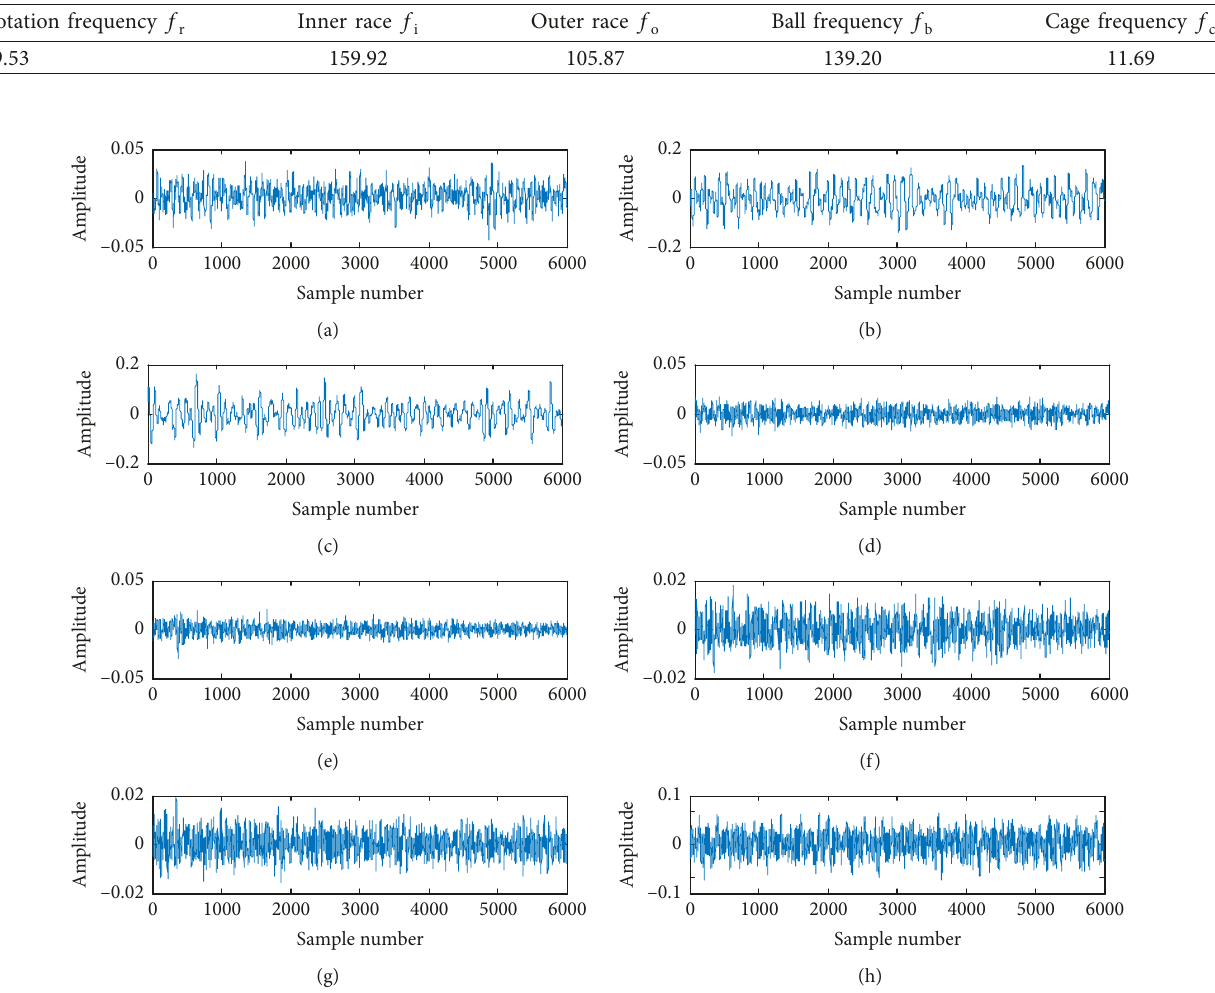
that represents the fourth ij DMD , X , X , X , X , X , X , and X , respectively. The 44DMD 45DMD 47DMD 41DMD 42DMD 43DMD 46DMD 48DMD